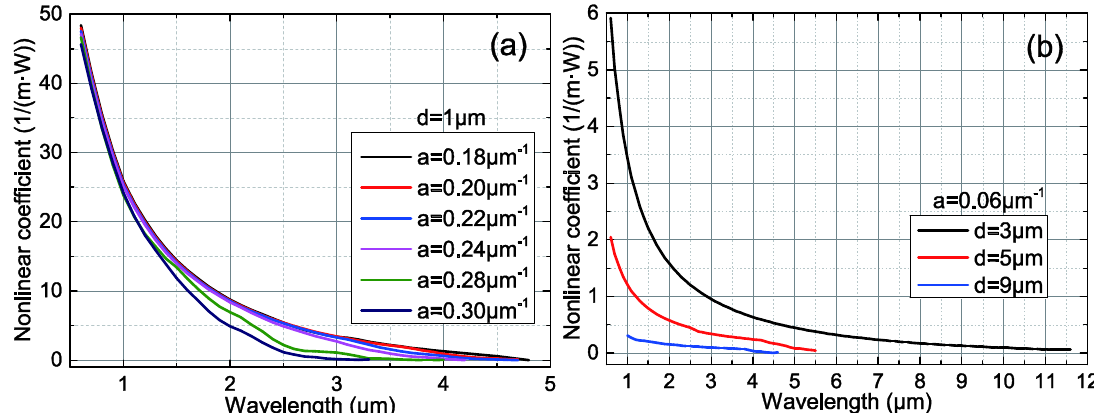
Figure 7. Impact of parameter ( a ) a , ( b ) d on the nonlinear coe ffi cient of FM.